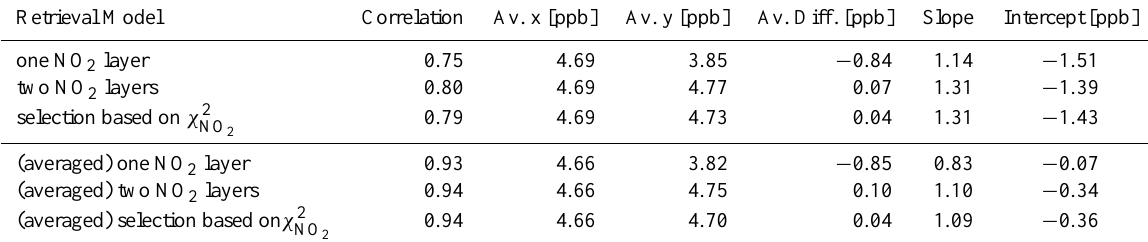
Table 3. Comparison of NO 2 volume mixing ratios derived from in-situ monitors and MAX-DOAS. The average difference is defined as (MAX-DOAS (y) minus in-situ (x)), and the linear fit parameters are defined for the in-situ values on the horizontal and the MAX-DOAS values on the vertical axis. The upper part of the table shows the results of the comparison when each observation is considered independent, the bottom part shows the results when all observations (within the five days) that fall within the same hour of the day are averaged prior to the statistical analysis (see Fig.